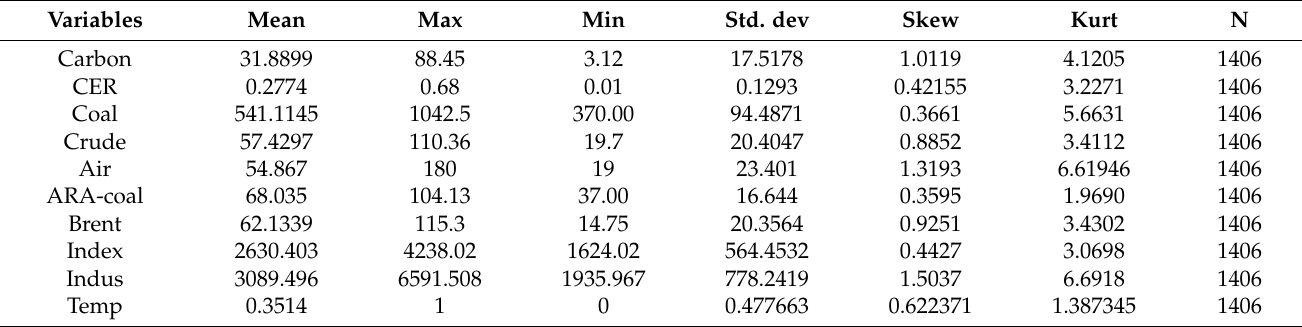
Table 3. Variable descriptive